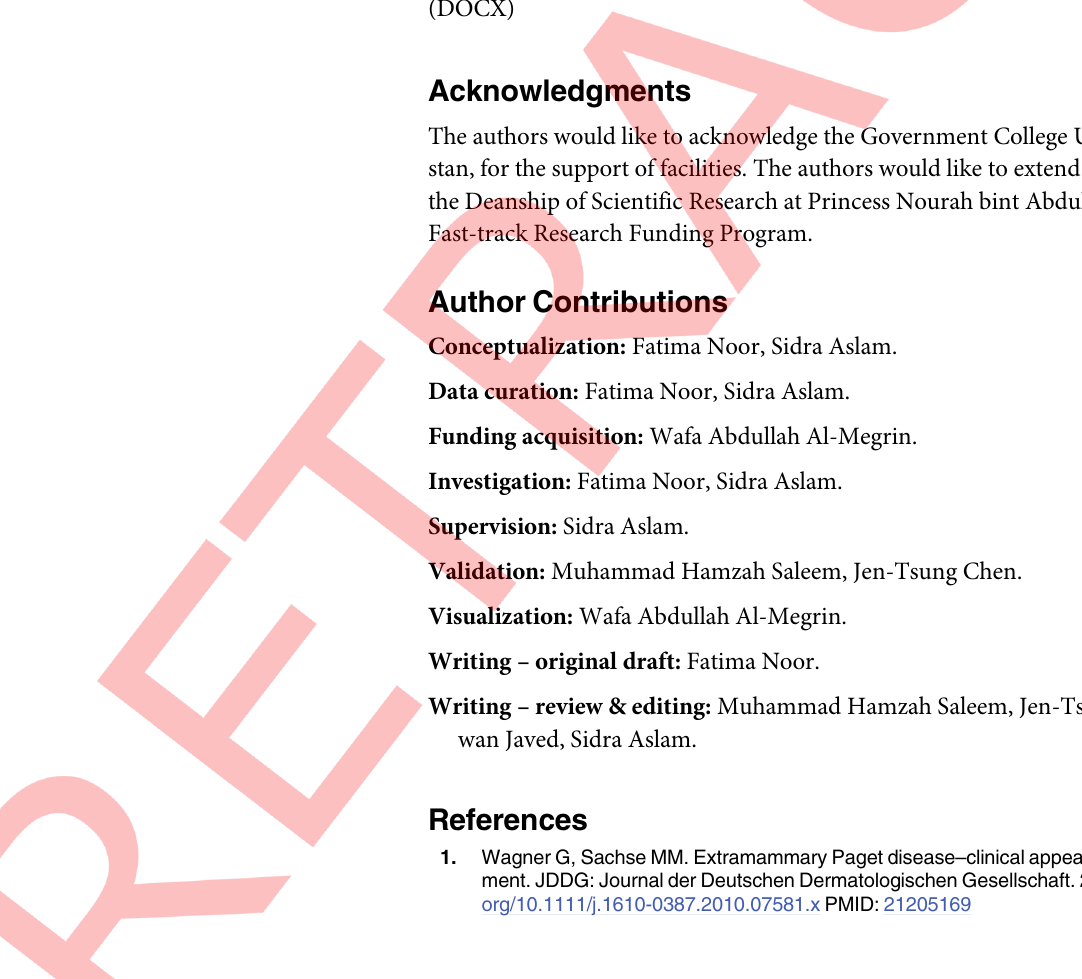
S1 Table. List of upregulated and downregulated